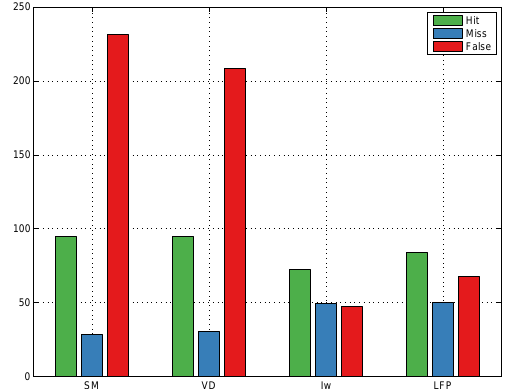
Figure 4. Validation of the different inundation approaches (bar bundles) for the Xynthia storm, on the grounds of the H , F and C rates (shown by different